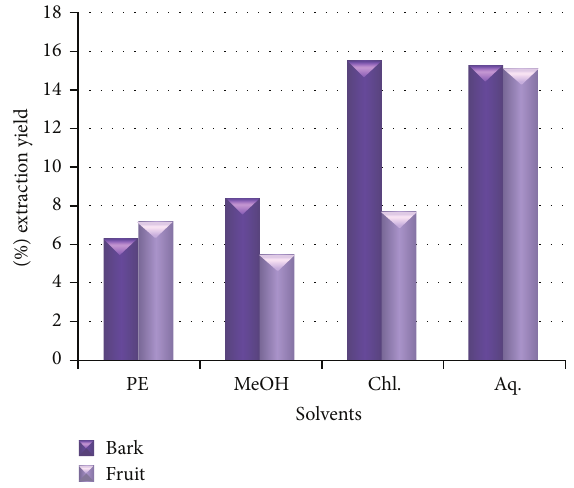
Figure 2: Percentage yield of different parts of C. ambrosioides .